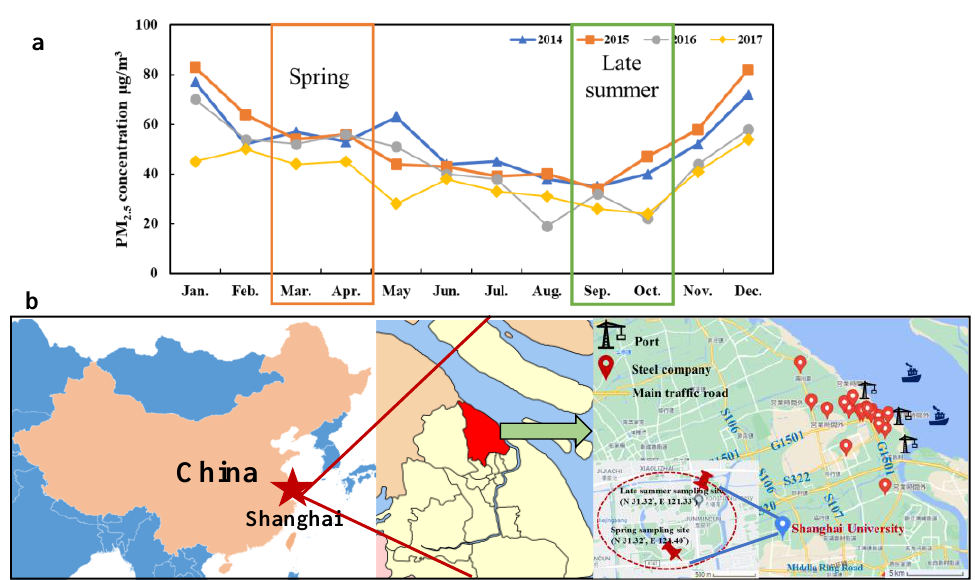
Figure 1. ( a ) Monthly PM 2.5 values collected from SEPB from 2014 to 2017; ( b ) location of the spring and late summer sampling sites in Shanghai (the red mark of the steel company appeared on Google maps using the ‘Baosteel’ keyword in Chinese).